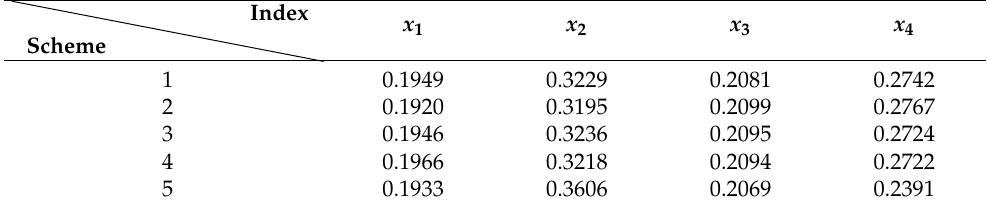
Table 6. Index variable